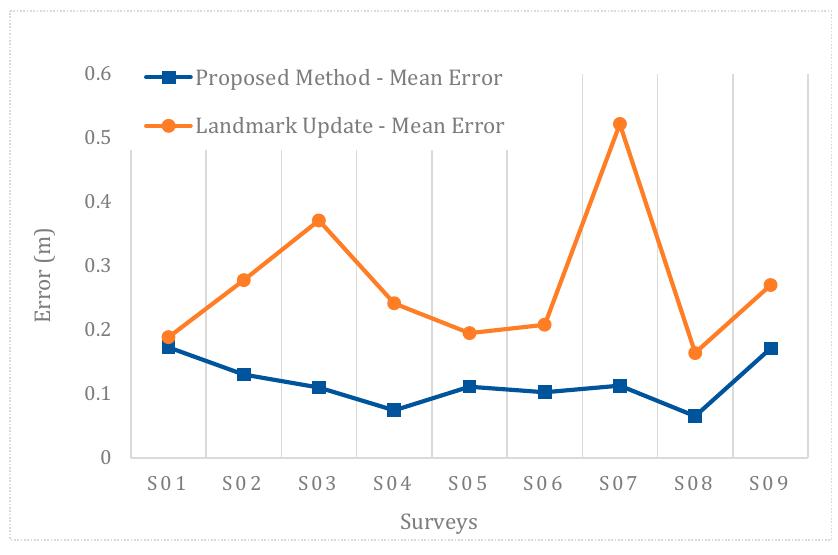
Figure 29. Total 2D error of the nine surveys by the landmark update method and by the proposed method.